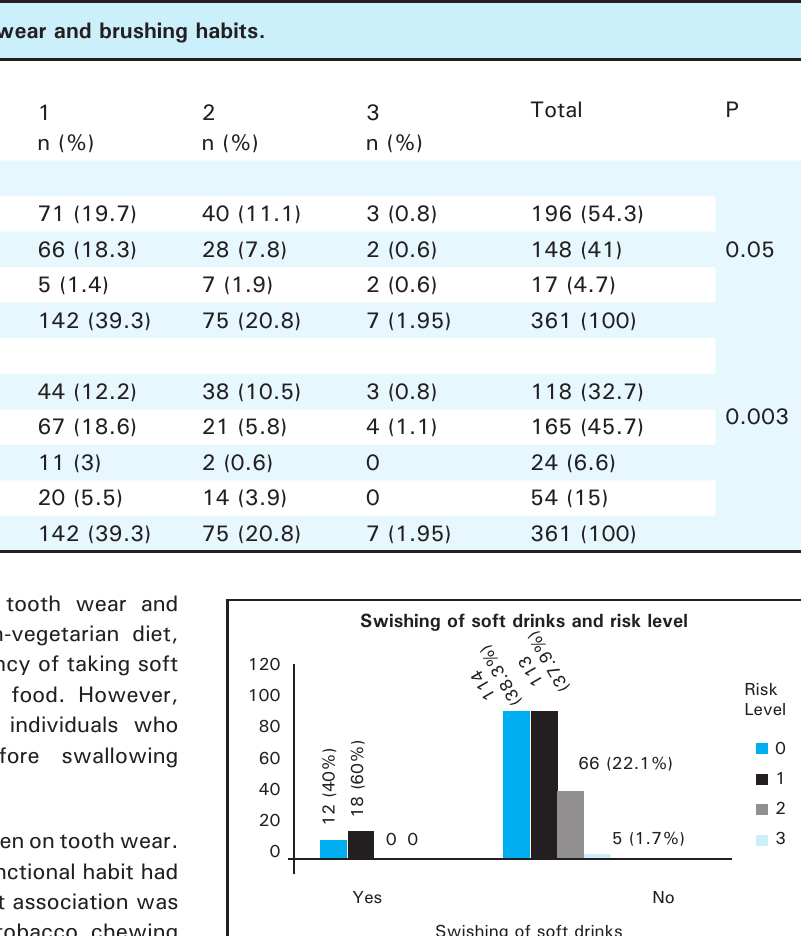
Brushing habits